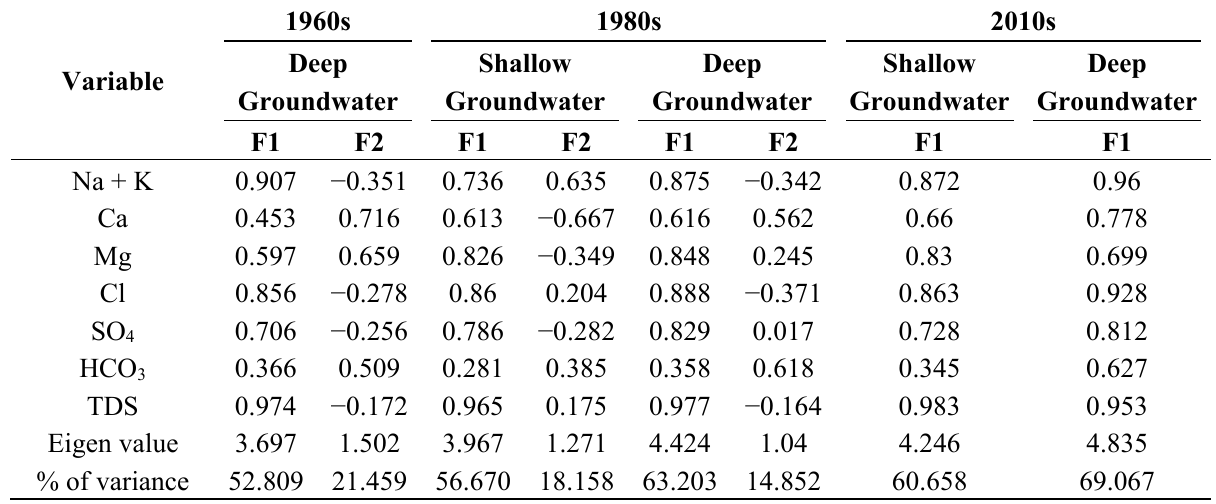
Table 3. Component matrix of groundwater major ions and TDS among decades by PCA.